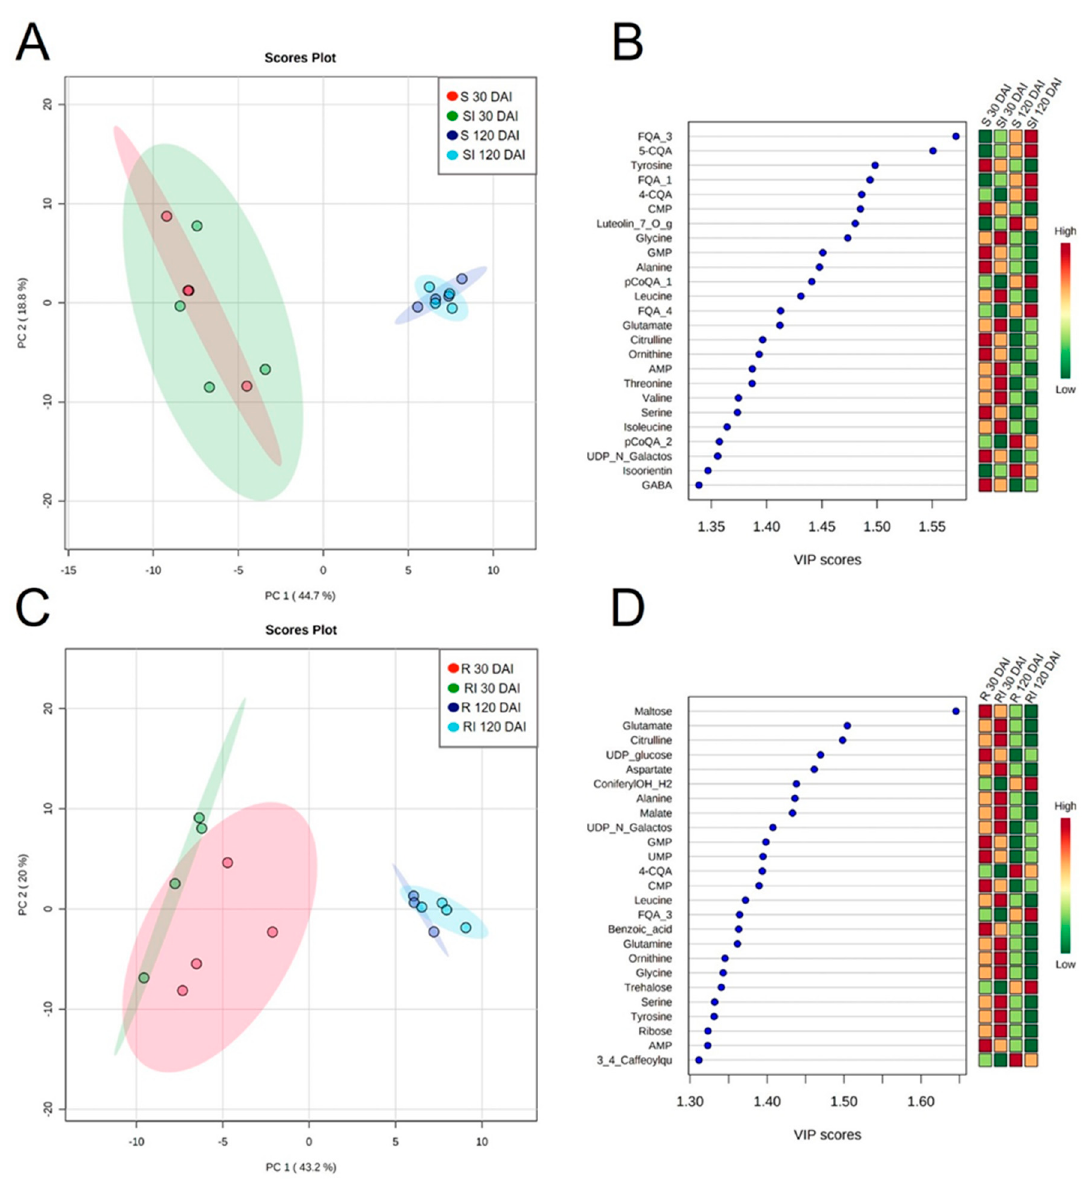
Figure 5. PCA clusters ( A , C ) and PLS-DA of the 25 most important features ( B , D ) of susceptible (S) and resistant (R) genotypes mock-inoculated or Lxx-inoculated (I) collected at 30 and 120 DAI quantified by targeted metabolomics. Biological replicates are represented by dots and shaded red, green, blue, and cyan ellipses represent 95% confidence intervals. Colors in the Variable Importance in Projection (VIP) plot represent relative intensity, where red represents the high values and green represents the low values. Abbreviations: FQA_3, feruloylquinic acid isomer 3; 5-CQA, 5-caffeoylquinic acid; CMP, cytidine monophosphate; Luteolin_7_O_glc, luteolin-7-O-glucoside; GMP; pCoQA_1; FQA_4; AMP; pCoQA_2; UDP_N_Galactos; GABA; UDP_glucose, ConyferylOH_H2; UMP; 4-CQA; FQA_3; AMP; 3_4_Caffeoylqu, 3,4-caffeoylquinic